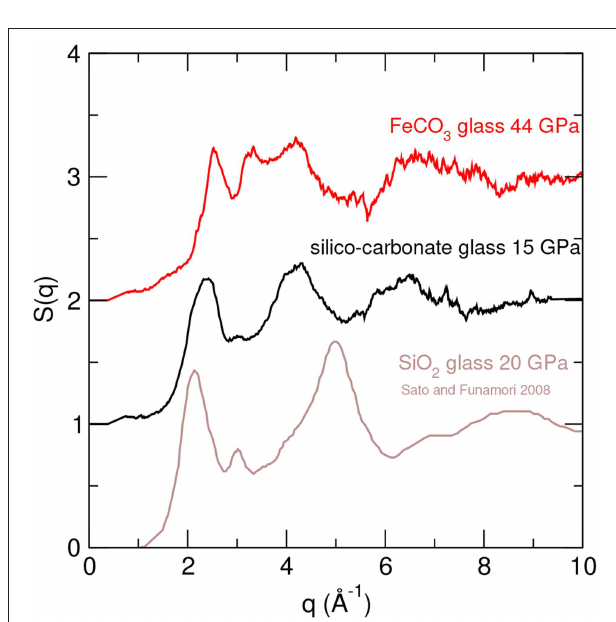
FIGURE 4 | Structure factor, S ( q ), for low P reacted FeCO 3 +SiO 2 glass (black), compared to SiO 2 glass at 20 GPa (Sato and Funamori, 2008) (brown) and FeCO 3 glass at 44 GPa (red). Low P sample 8 (15 GPa) shows intermediate structure between SiO 2 glass and high P FeCO 3 glasses.